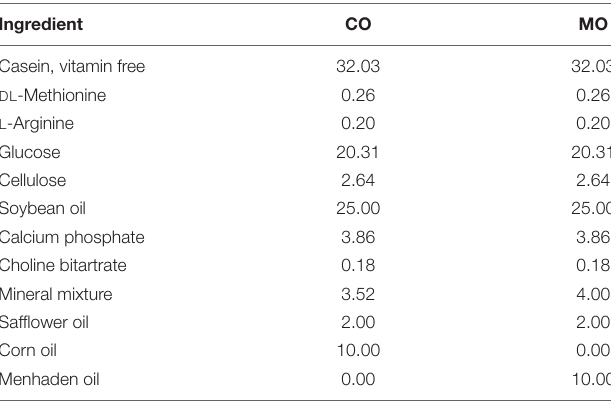
TABLE 1 | Composition of corn oil- (“CO”) and menhaden oil- (“MO”) enriched diets (expressed as % dry mass).